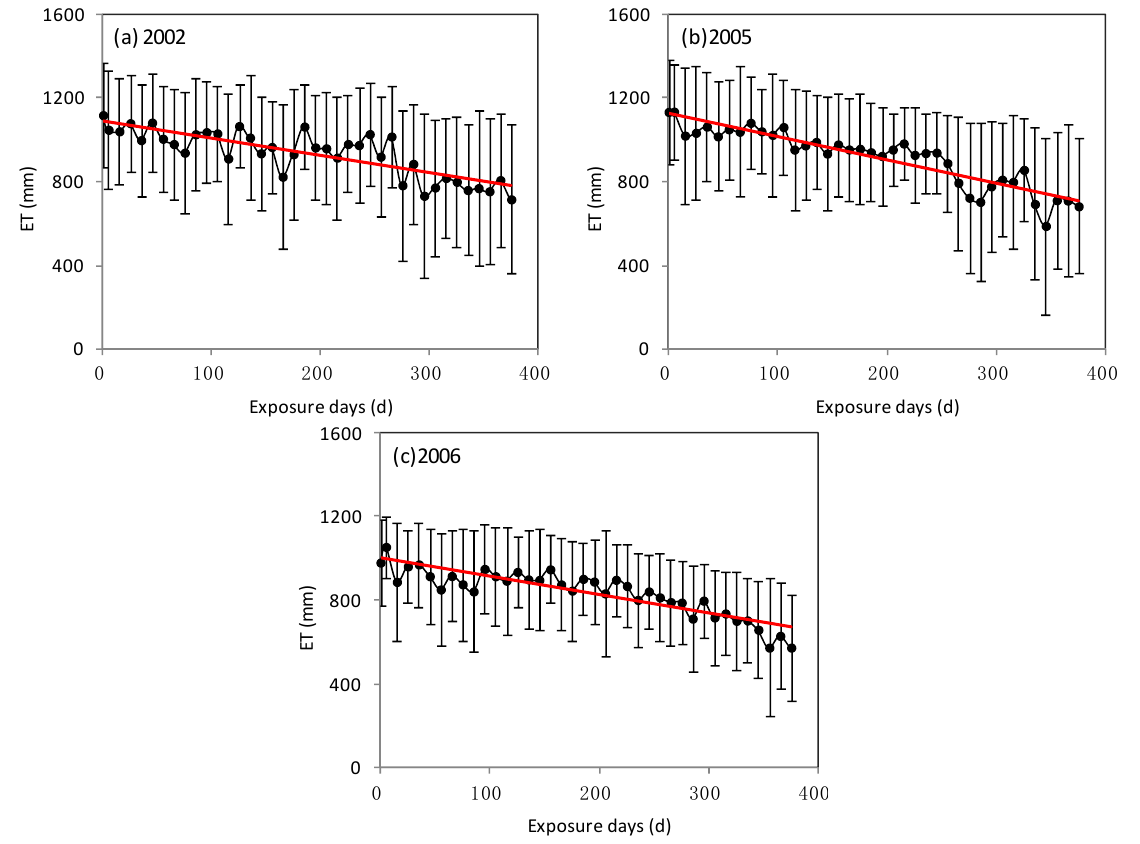
Figure 7. Relationship between exposure days and annual ET in the Poyang Lake wetland in ( a ) 2002; ( b ) 2005, and ( c )